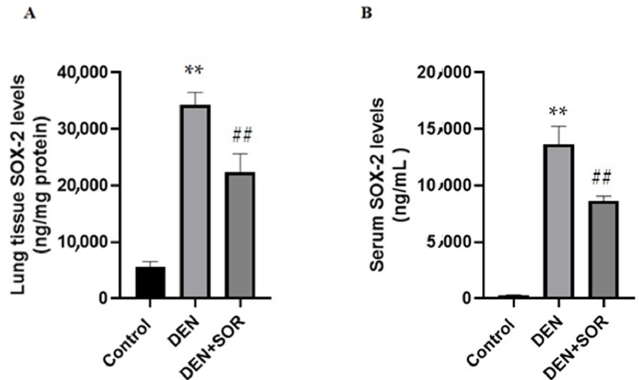
Figure 1. Effects of SOR on lung tissue ( A ) and serum ( B ) SOX-2 levels. ( n = 10) Data are expressed as the mean ± standard deviation (mean ± 2 SD) ** p < 0.001 compared with the control group, ## p < 0.001 compared with DEN group DEN: diethylnitrosamine; SOR: Sorafenib; SOX-2: Sex-determining region Y (SRY)-box 2. Rats Compared with the control animals (19.09 ± 0.84 pg/mg protein), DEN elevated the TNF- α protein level in lung tissue significantly (50.06 ± 1.00 pg/mg protein, p < 0.001). The DEN-induced elevation of TNF- α protein level was prevented by SOR treatment (27.64 ± 1.75 pg/mg protein, p < 0.001), (Figure 2). Figure 2. Effects of SOR on TNF- α in lung tissue. ( n = 10) Data are expressed as mean ± standard deviation (mean ± 2 SD). ** p < 0.001 compared with control group, ## p < 0.001 compared with DEN group DEN: diethylnitrosamine; SOR: Sorafenib; TNF- α : Tumor necrosis factor alpha. 2.3. Effect of SOR Treatment on Lung IL-1 β Levels in DEN-Induced Lung Carcinogenesis in Rats In control rats, the lung tissue IL-1 β level was 47.85 ± 1.65 pg/mg protein which was elevated marked in DEN-injected rats (100.95 ± 2.35 mg protein, p < 0.001). The DEN-in- duced rises in lung tissue IL-1 β levels were reduced (65.26 ± 0.85 pg/mg protein, p < 0.001) with treatments of SOR (Figure 3).